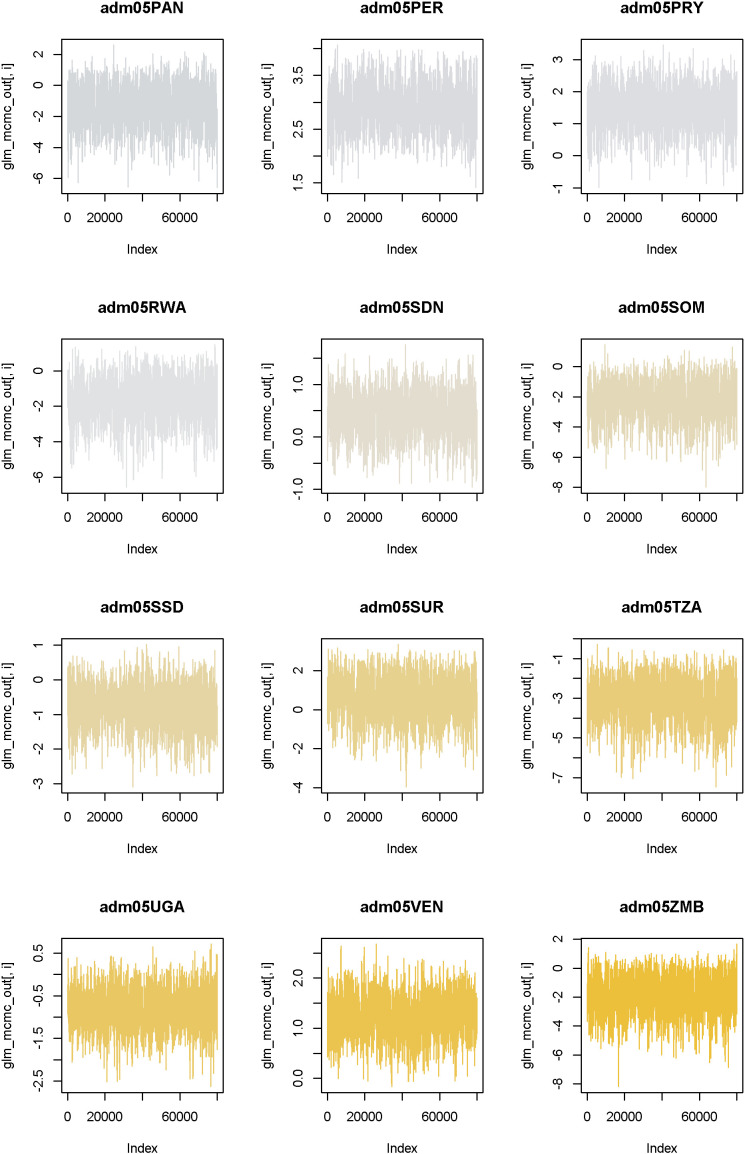
Trace plots from estimation of model variant 17 as an example of convergence.